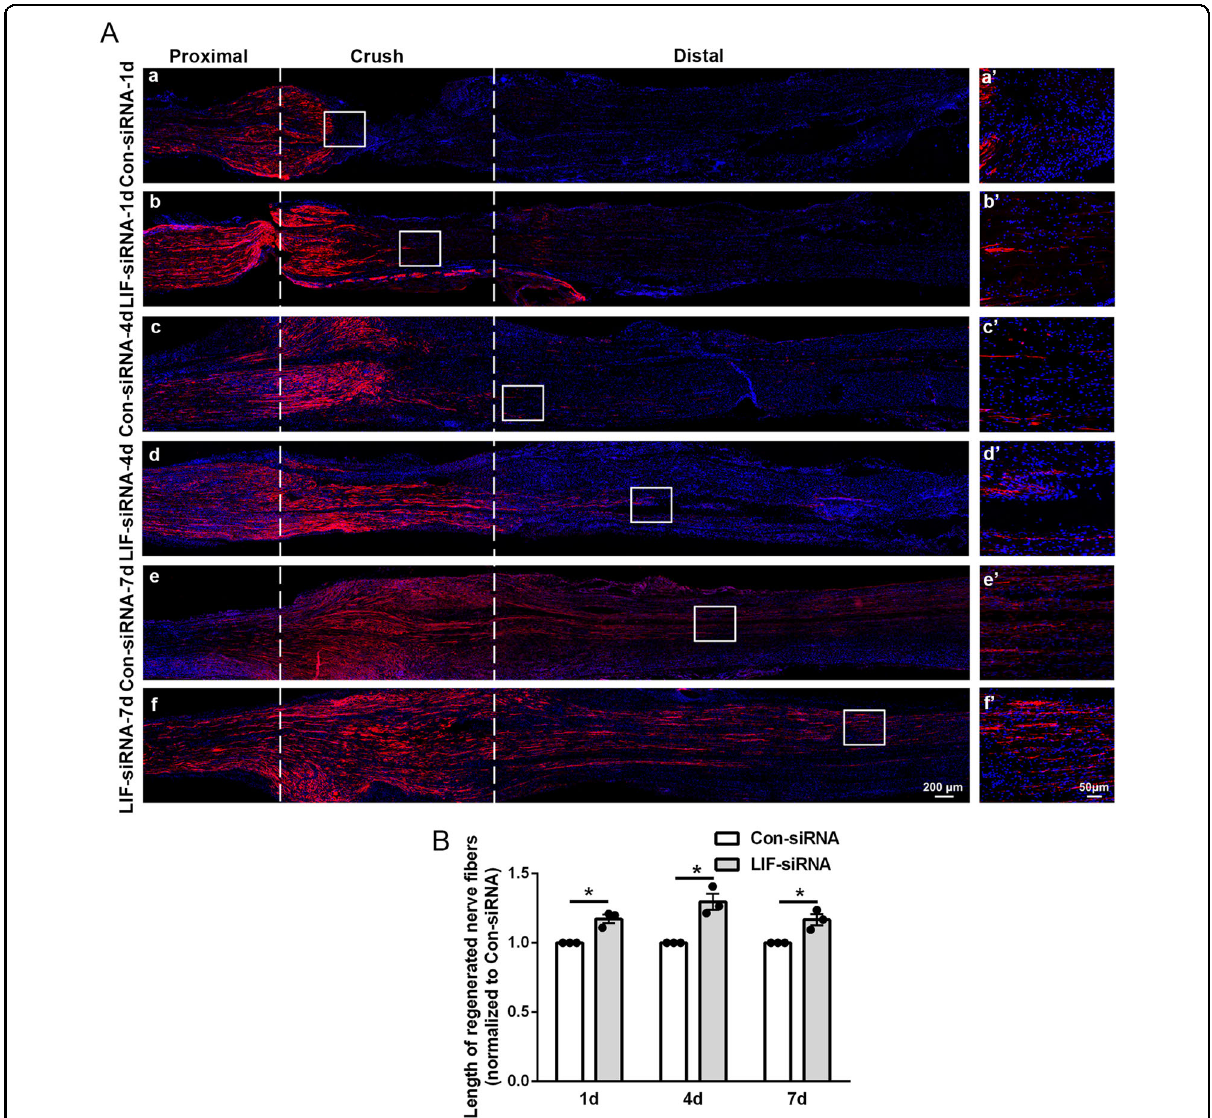
Fig. 4 LIF-siRNA promotes axon elongation. A Representative immunostaining images of sciatic nerve longitude sections of rats injected with control-siRNA or LIF-siRNA. Rat sciatic nerve segments are collected at (a and b) 1 day, (c and d) 4 days, and (e and f) 7 days after nerve crush. Injured areas (proximal segments, crush sites, and distal segments) are labeled with dashed lines. Red color indicates SCG10 and blue color indicates nucleus. Boxed areas are demonstrated at a higher magni fi cation on the right. Scale bars indicate 200 μ m in main images and 50 μ m in magni fi ed images. B Quanti fi cation of the relative length of elongated axons in rats injected with control-siRNA or LIF-siRNA at 1 day, 4 days, and 7 days after nerve crush injury. Data were presented as means ± SEM. * p value <0.05 versus control-siRNA